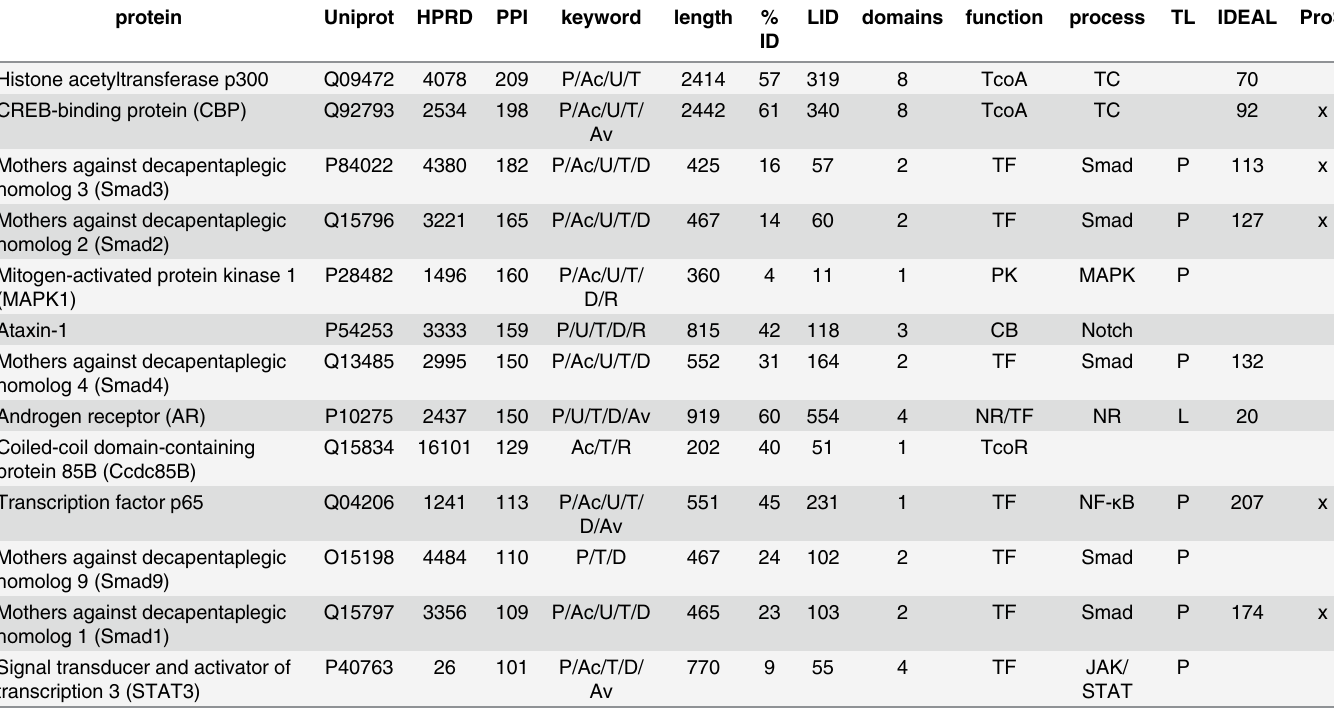
Table 1. Hub proteins localized in both the nucleus and cytoplasm, annotated by PTM * and transcription * (more than 100 PPIs) protein Uniprot HPRD PPI